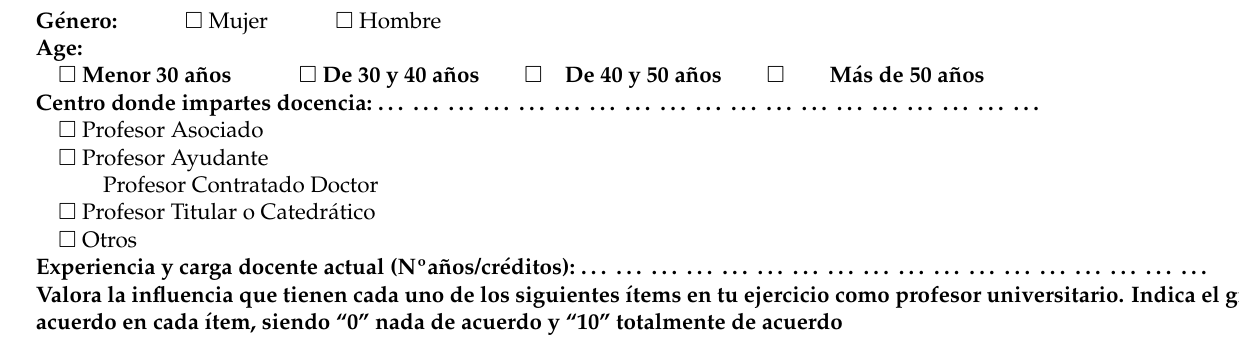
Table A1. Cuestionario Sobre Motivaciones del Profesorado Universitario.